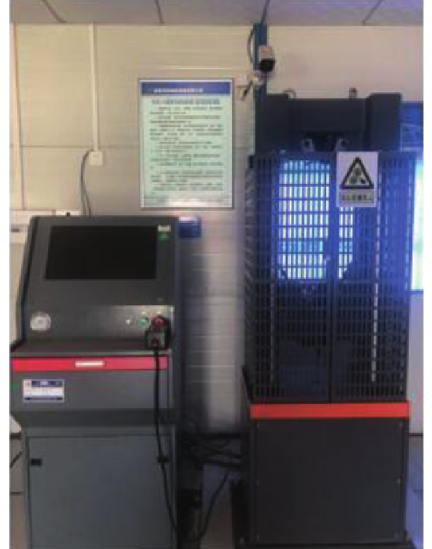
Figure 2: Photograph of WAW-100 in laboratory.